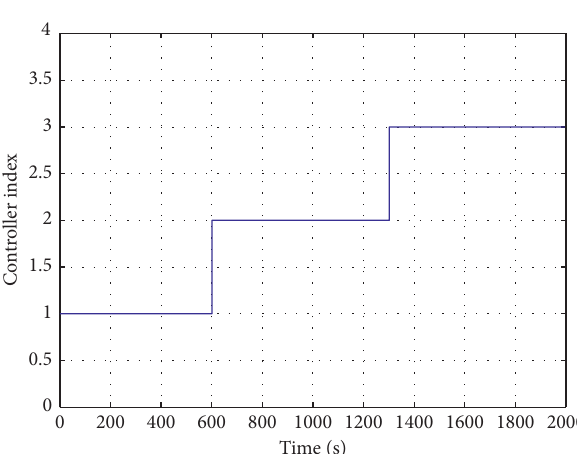
Figure 8: Switching sequence of